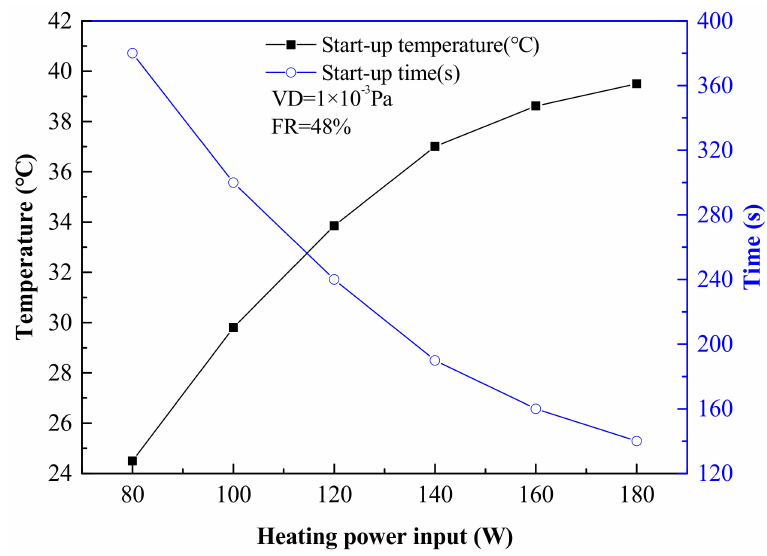
Figure 6. Effects of heating power input on start-up performance of the plate gravity heat pipe (PGHP).